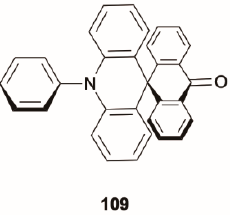
Scheme 38. Chemical structure of compound 109